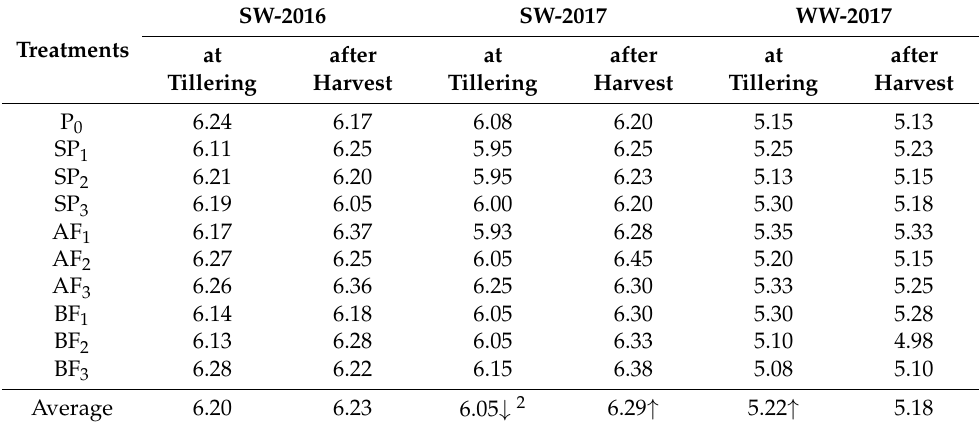
Table 6. Soil pH in the experiments, in 1 M KCl 1